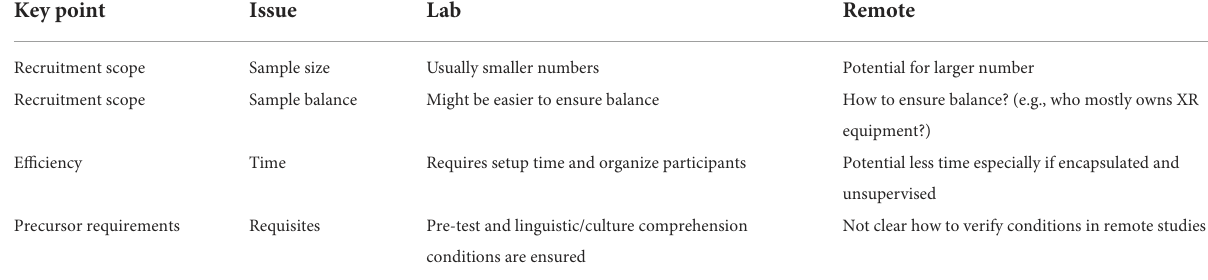
TABLE 2 Study participants key